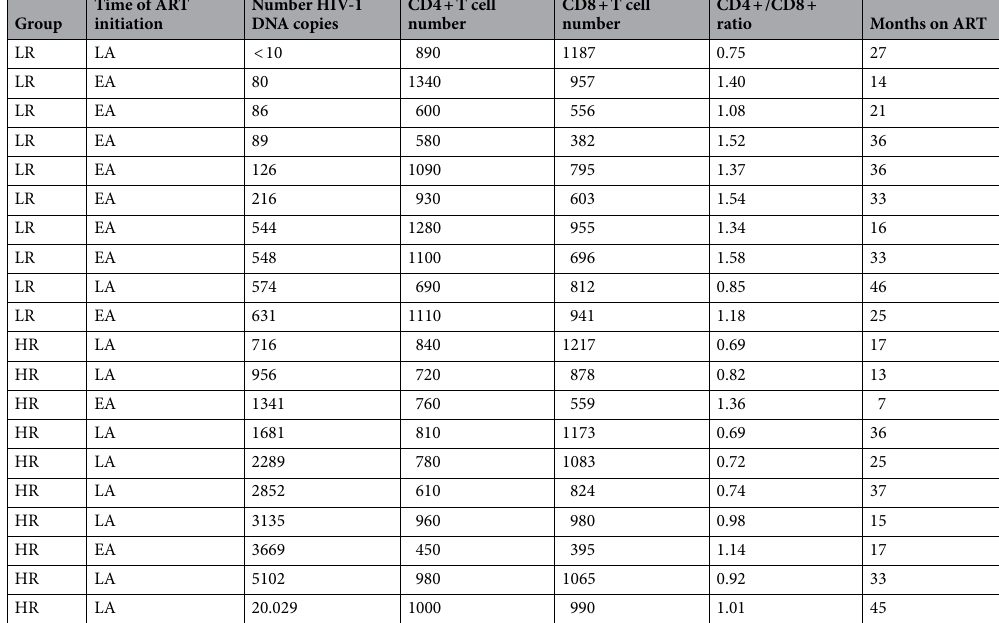
Table 1. Clinical and immunological data of patients included in the study. LR low reservoir, HR high reservoir, EA early ART, LA late